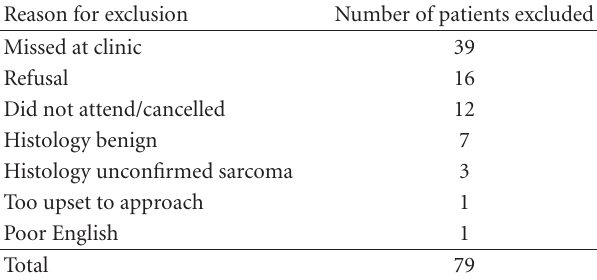
Table 2: Reasons for excluding patients.